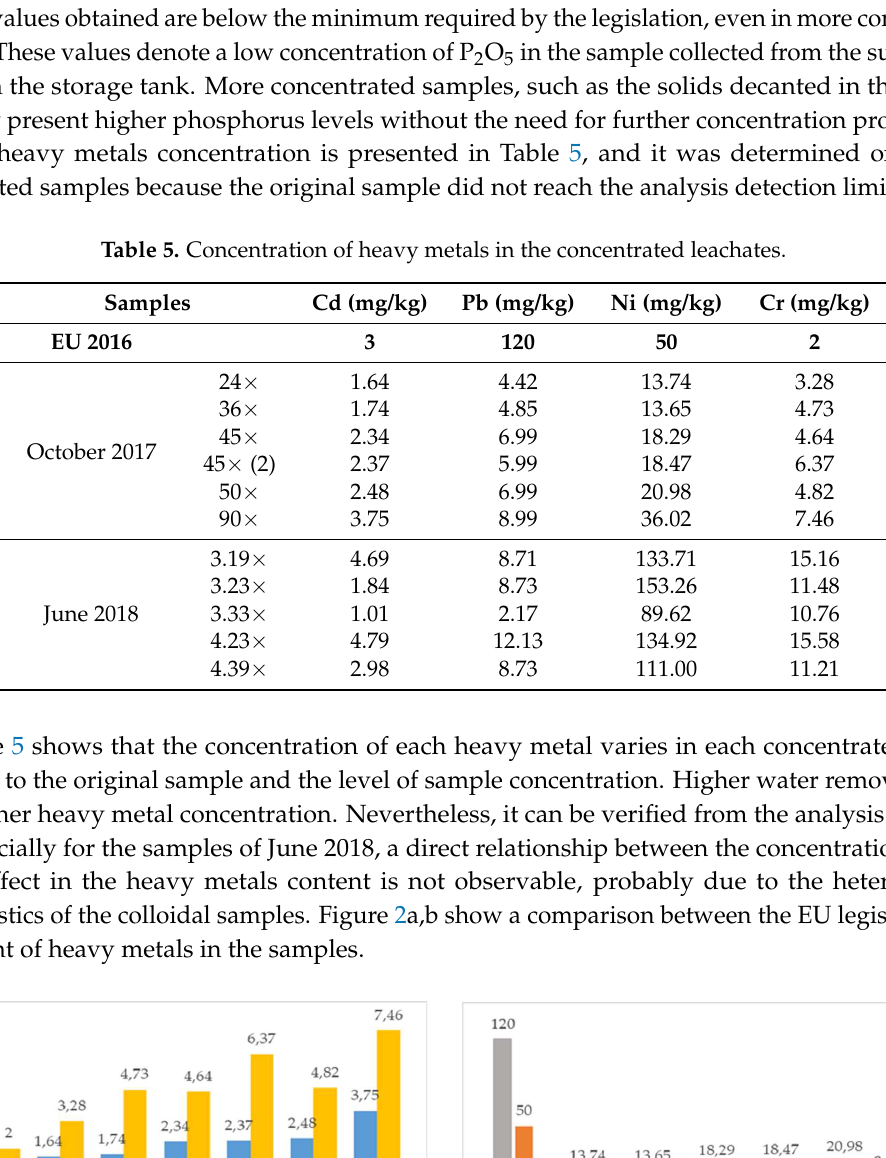
( b ) Figure 2. Concentration of heavy metals in the concentrated leachates. ( a ) from October 2017; ( b ) from June 2018. As shown in Figure 2a,b, the content of Pb fulfills the requirements of the EU legislation in all concentrated samples produced. However, Cd, Cr and Ni must be removed to achieve the fertilizer requirements. From the analysis of original and concentrated leachate samples, a simplified flowsheet for a sequence of composition adjustments for the leachate can now be proposed, as presented in Figure 3. Figure 3. Proposed simplified flowsheet for a conversion process of the leachate to commercial fertilizers. This flowsheet represents a proposal for the main operations that the leachate must pass through to reach the minimum legislation requirements for commercial fertilizers. The specific processes for each conversion step must be selected and designed, considering the general composition of the liquid leachate and its possible variation.